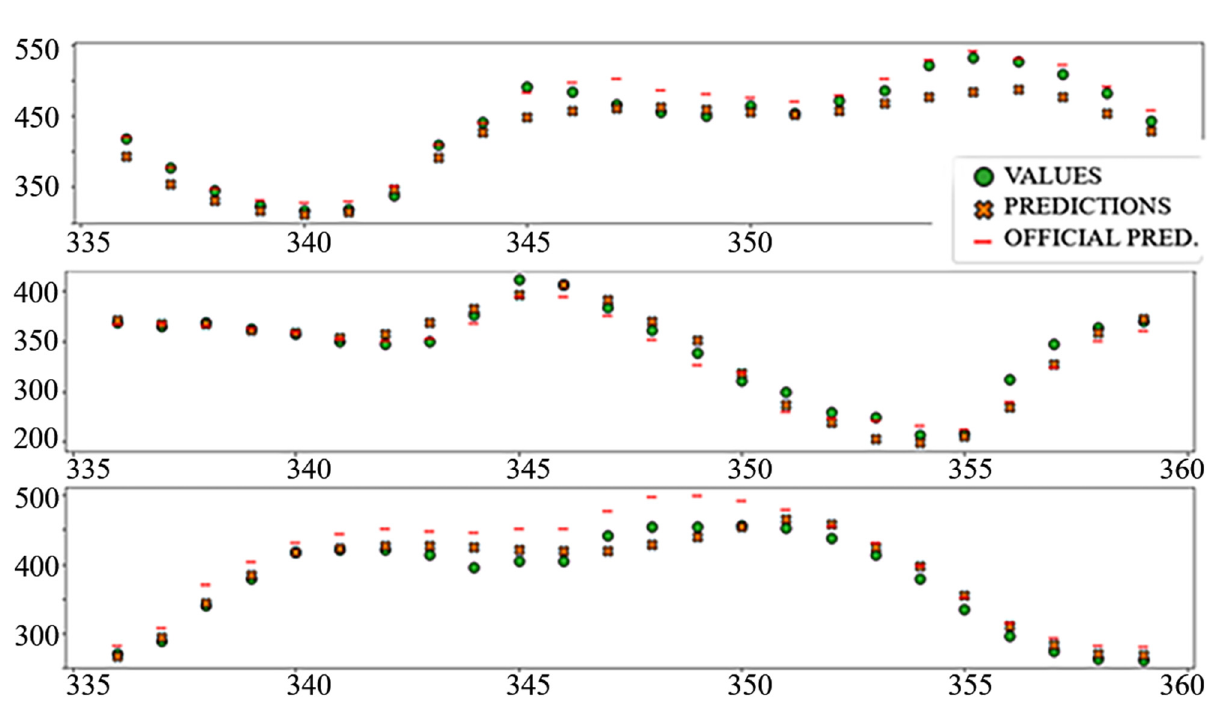
Figure 16. Load prediction: “Dense” model.